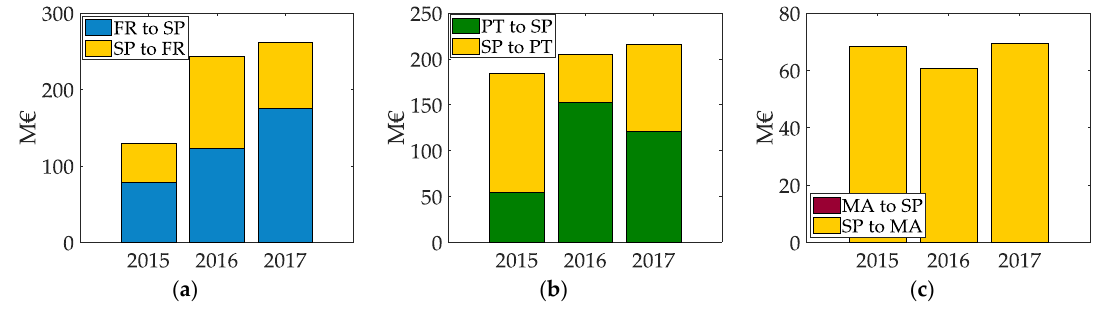
Figure 8. 2015–2017. Annual amounts of renewable premiums (M € ) ‘transferred’ (exported) through